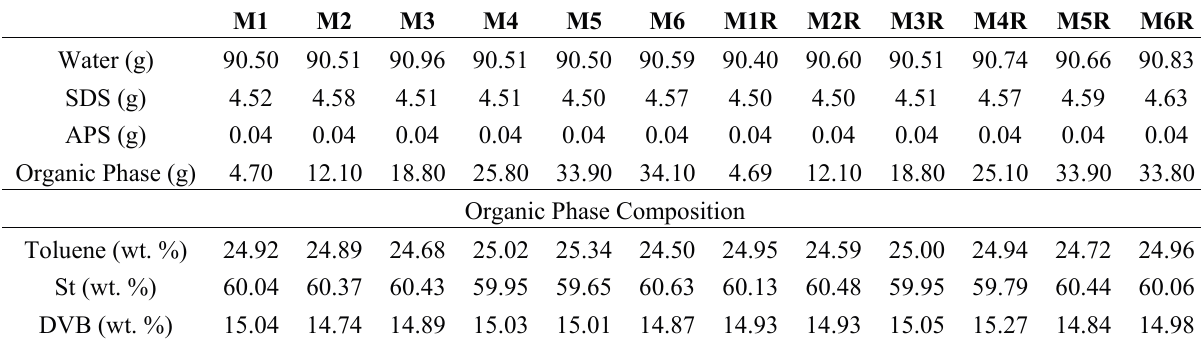
Table 5. Formulations used in the polymerizations at the organic-phase dosing rate of 0.15